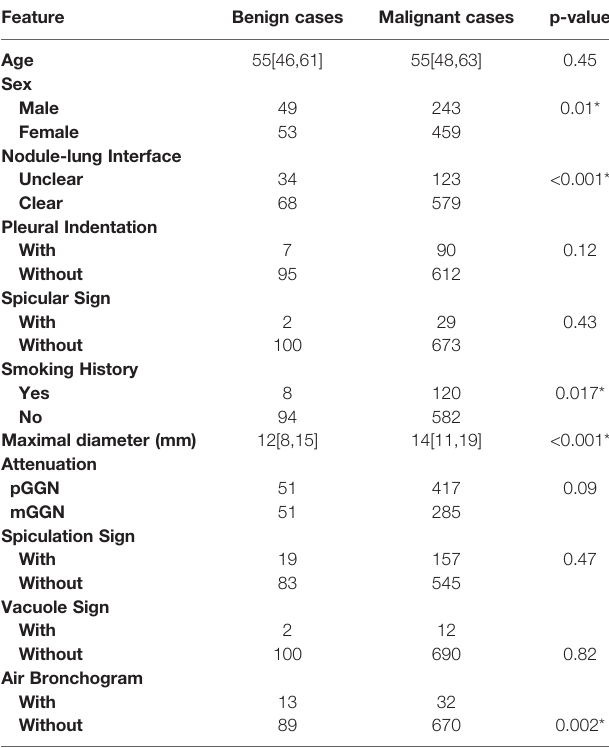
TABLE 2 | Statistical analysis of clinical features between the malignant and benign cases in the Changzheng Dataset.